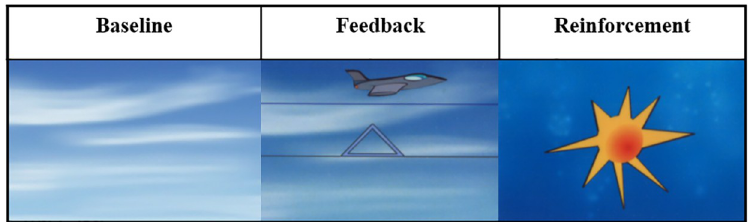
Fig 1. SCP feedback. Baseline is calculated for 2s, followed by and 8s feedback. If the object (airplane) is kept in the same direction as is prompted (where the triangle points), a sun is displayed (reinforcement).